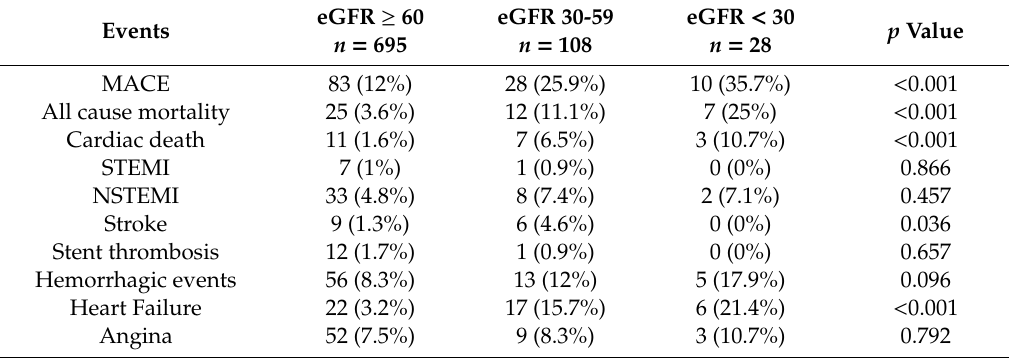
Figure 3. Kaplan Meier analysis for the probability of MACE event-free survival according to renal function. Table 4. Outcomes at one-year follow-up according to baseline renal